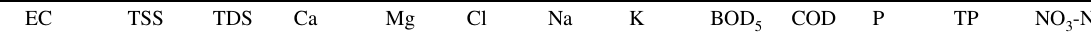
Table 1 Correlation matrix of influent